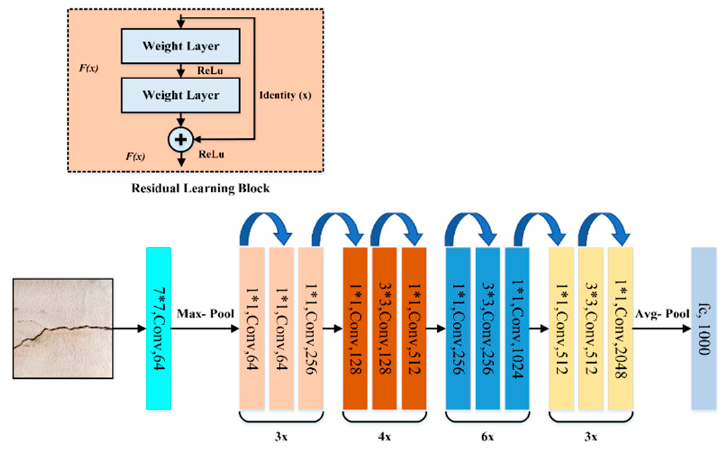
Figure 6. The architecture of ResNet-50 model.